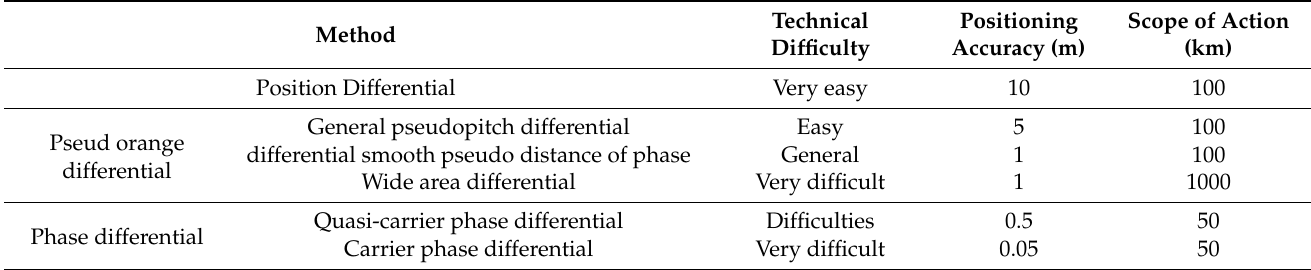
Table 7. Performance comparison of GPS measurement methods.